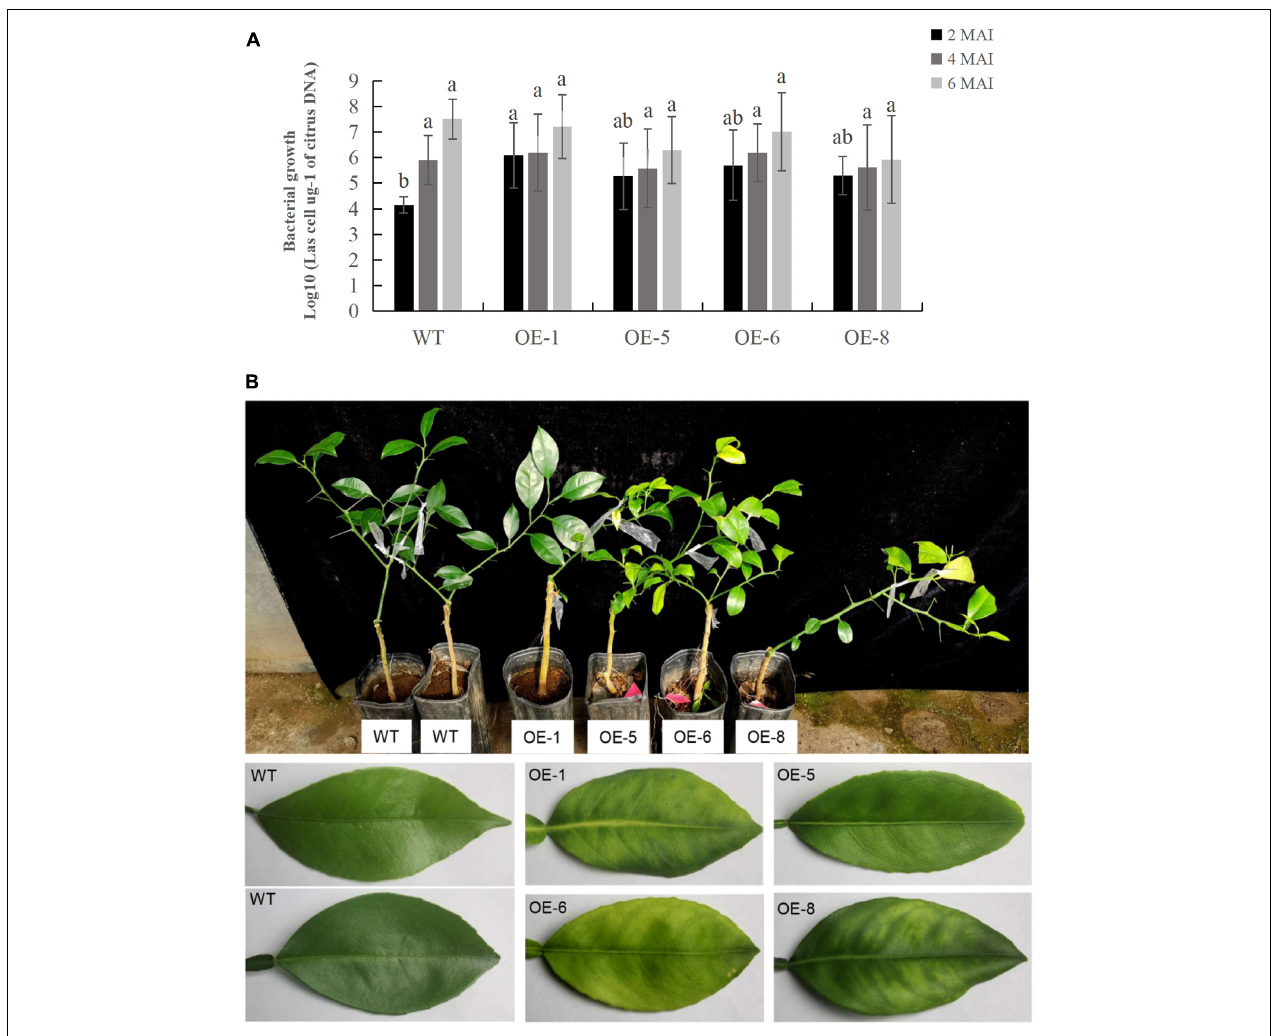
FIGURE 6 | Evaluation of Citrus Huanglongbing (HLB) resistance in transgenic plants grown in a greenhouse. (A) Quantitative analysis of Ca Las growth at 2, 4, and 6 months after infection (MAI). The bacterial populations ( Ca Las cells µ g - 1 of citrus DNA) were determined using qPCR. Standard errors were calculated from three to five plants per line. Different letters on top of the bars indicates significant differences from the WT control ( p < 0.05, Student’s t test). (B) HLB symptoms in the transgenic plants and wild type (WT) controls after 6 MAI. WT, wild type; OE-#, transgenic